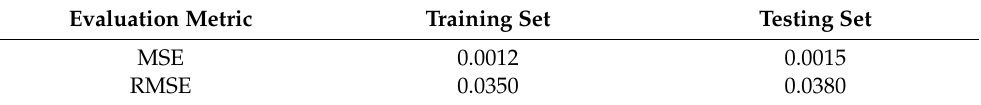
Figure 10. Residual distribution plot for ( a ) training set, and ( b ) testing set. Table 8. MSE and RMSE values achieved by the ANFIS model for both training and testing datasets.